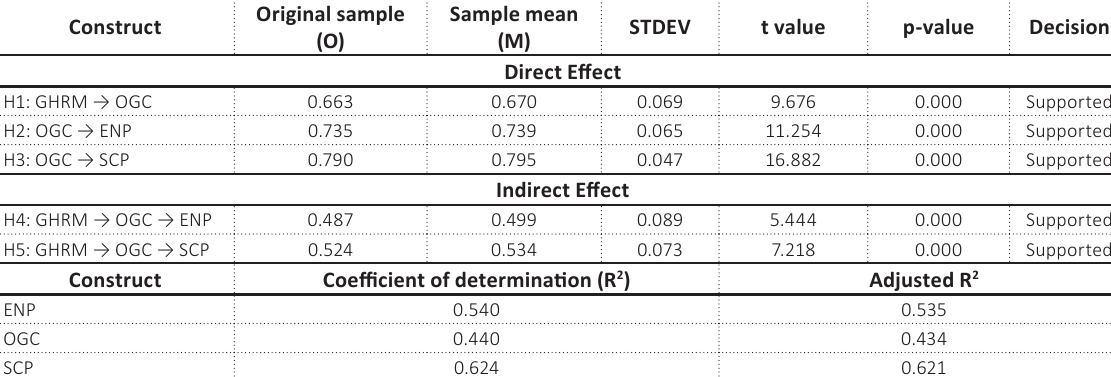
Table 4. Hypotheses testing (direct and indirect effect)